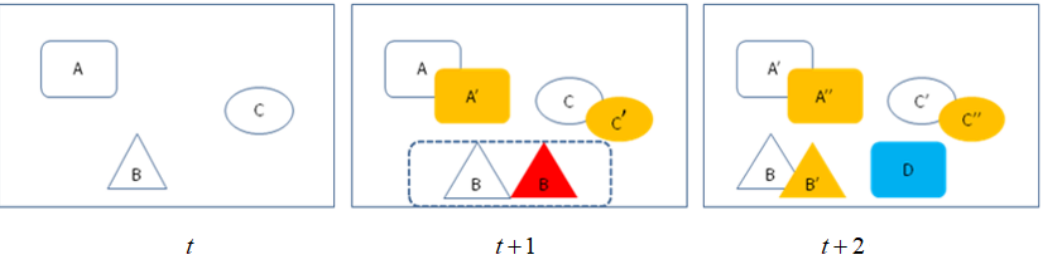
Figure 4. Data correlation scenario in multitarget tracking (the yellow represents target tracked correctly; red represents target of last frame was not detected at current frame; blue represents new target). At time t , tracklet includes three targets; At time t + 1, target B wasn’t detected; at time t + 2, new target D was